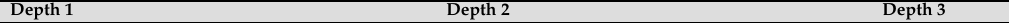
Table 1. Architecture of a Three-Way Digital Healthcare System for the People with Disabilities and Their